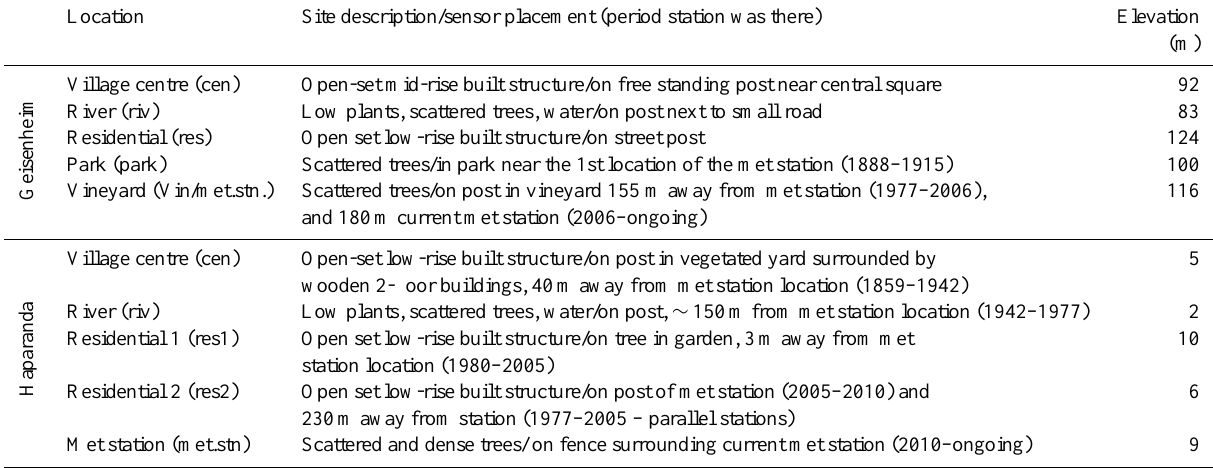
Table 2. Description of temperature sensor network. Location Site description/sensor placement (period station was